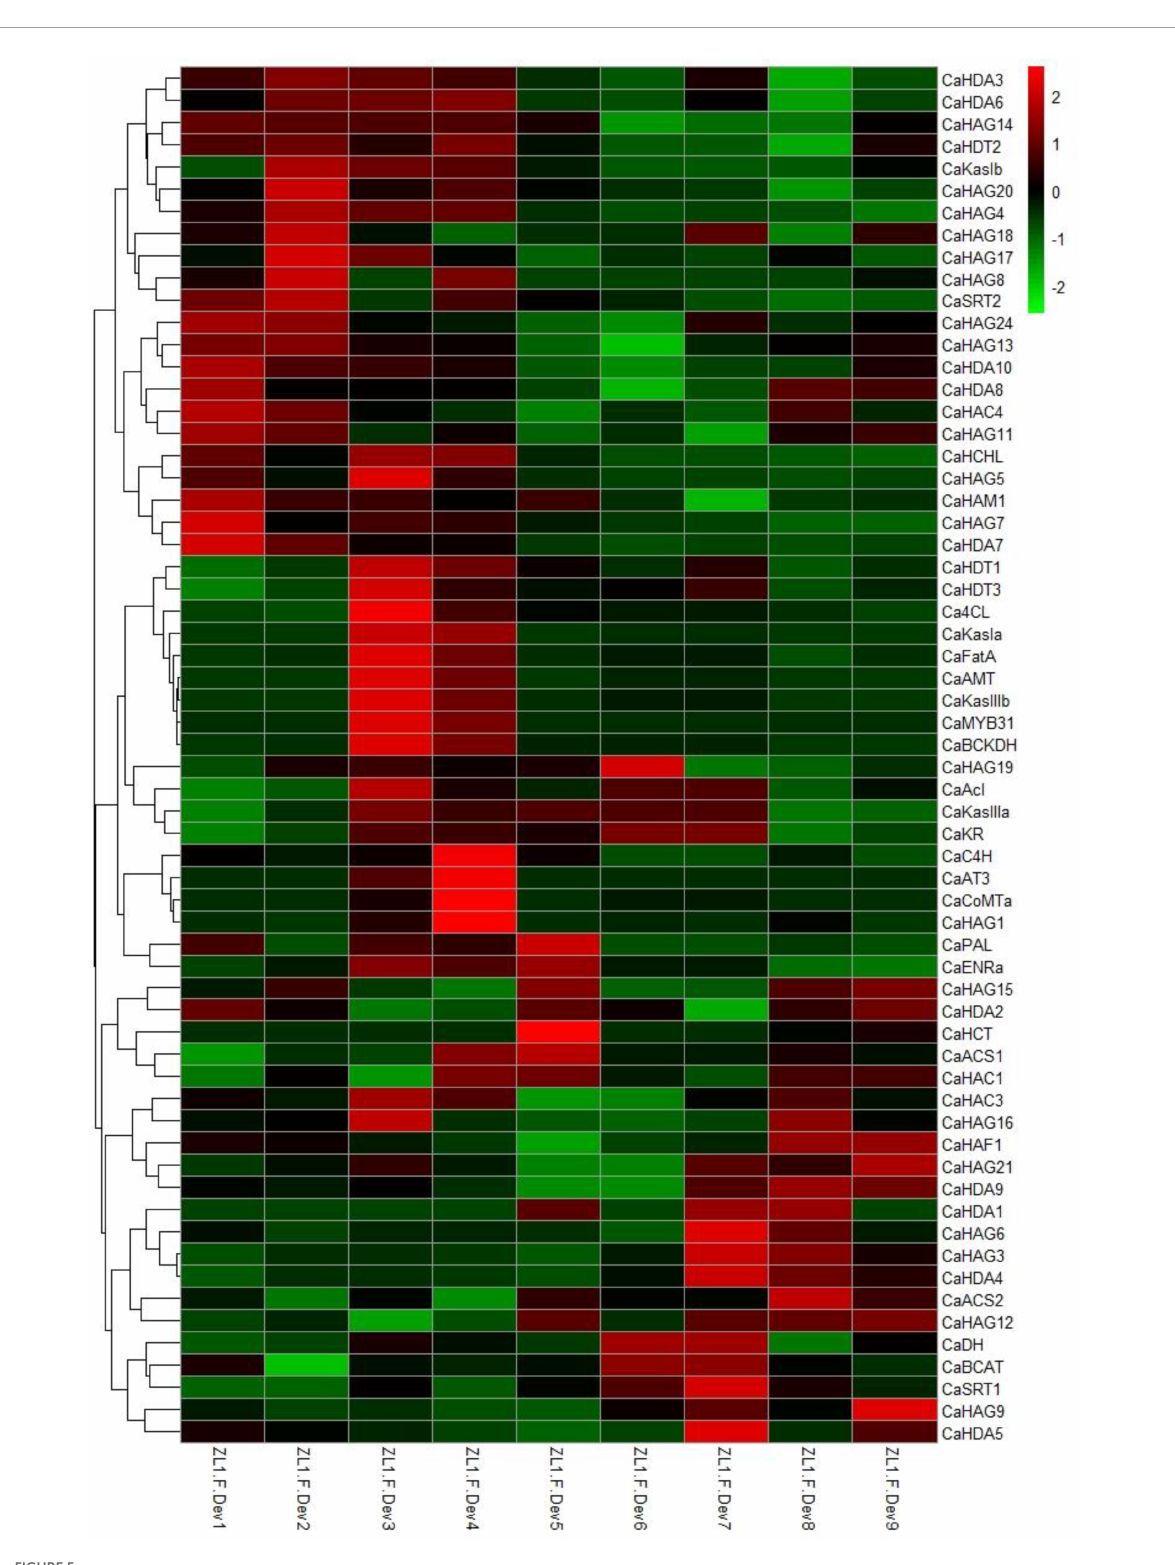
FIGURE5 Expression profiles of CaHATs , CaHDACs, and capsaicinoid regulatory and biosynthetic genes. The heat map includes 19 capsaicinoid biosynthetic genes and one regulatory gene CaMYB31 . The heat map was constructed by values of fragments per kilobase of exon per million fragments (FPKM). The expression data were retrieved from “Zunla-1” transcriptome (Qin et al.,